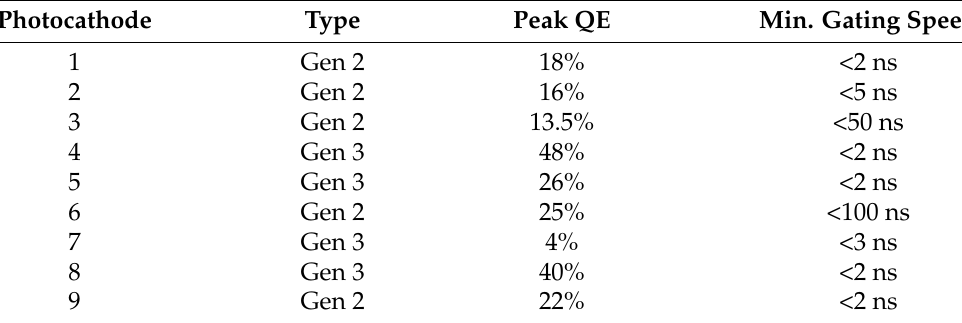
Figure 20. The time gating principle of ICCDs. Table 6. Photocathodes mounted on the commercial Andor